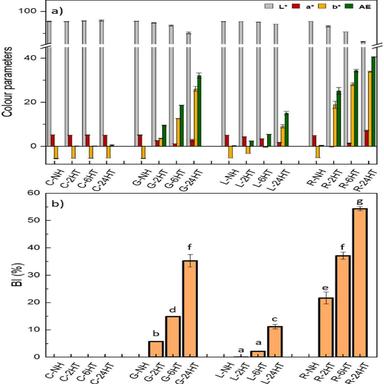
a) L\, a\, b\ and total colour difference (ΔE\), and b) browning index percentage, of gelatin-based films as a function of saccharide (glucose (G), lactose (L), and ribose (R)) and heating time (non-heated (NH), heat-treated (HT) for 2, 6 and 24 h). Films with no saccharide were used as control (C). (n = 9). Two means followed by the same letter are not significantly (p > 0.05) different according to the Tukey's multiple range test. (For interpretation of the references to colour in this figure legend, the